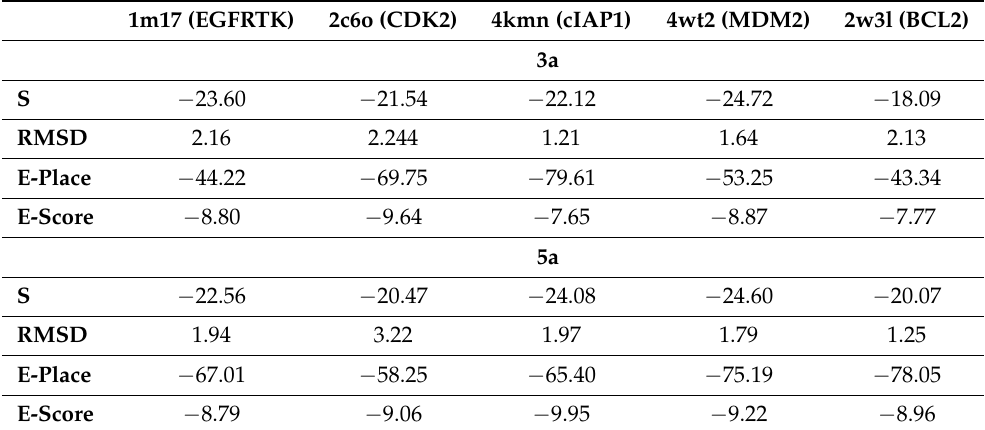
Table 3. Tested compounds 3a and 5a energy readings against (1m17, 2c6o, 4kmn, 4wt2,